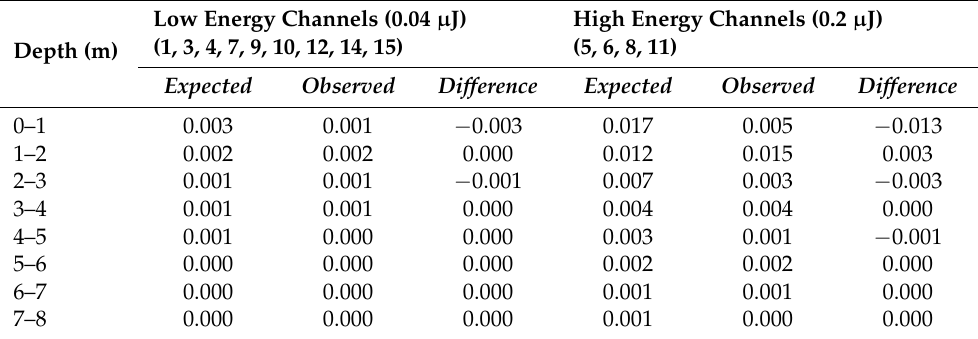
Table 4. Average expected and observed numbers of photoelectrons per pulse for the reclassified low- and high-energy channels, which reflect the “as flown” energy